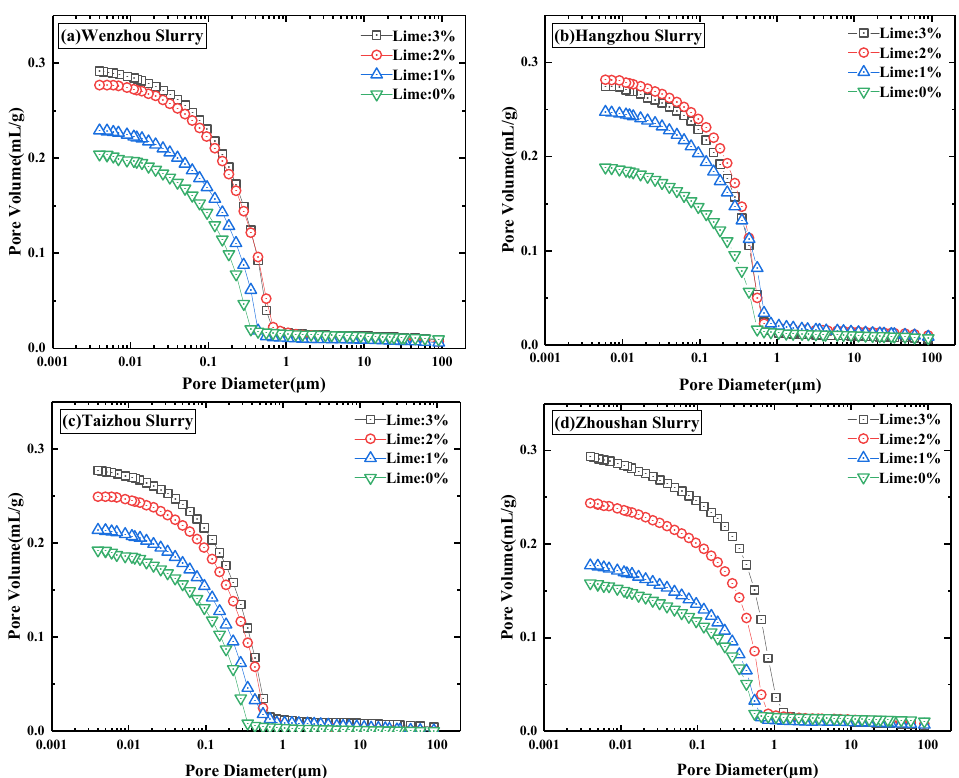
Figure 6. Cumulative mercury injection curve of stabilized slurry for each group with different lime dosages. ( a ) Wenzhou soil sample, ( b ) Hangzhou soil sample, ( c ) Taizhou soil sample, ( d ) Zhoushan soil sample.